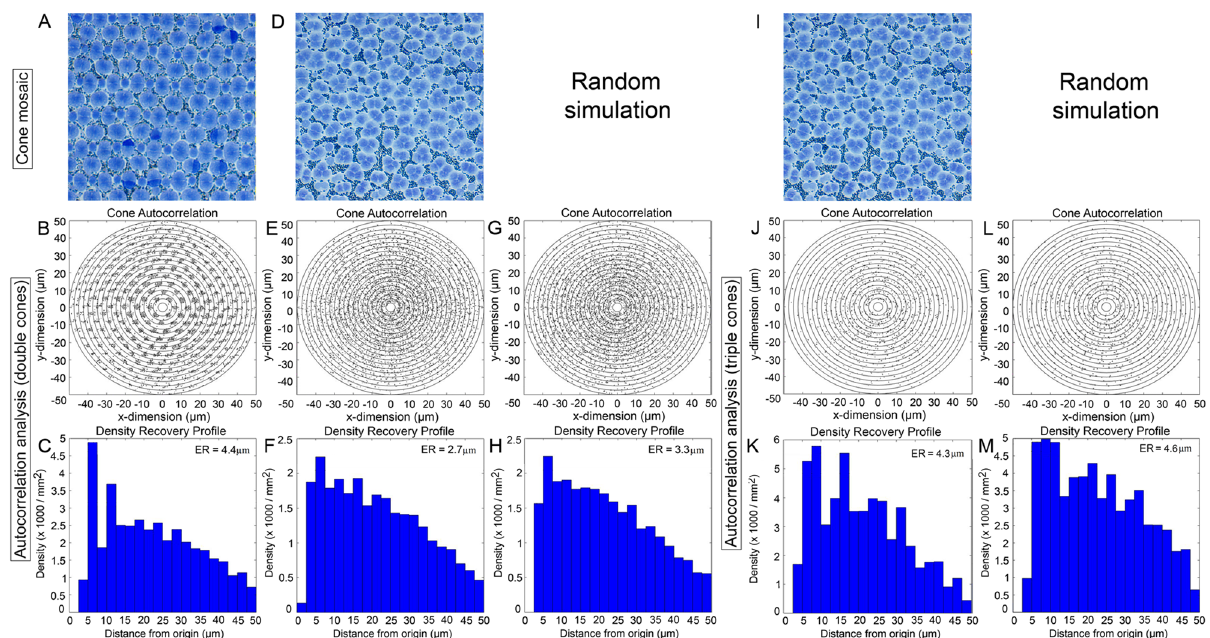
Figure 13. Autocorrelogram and density recovery profile for the double cone ( A – F ) and triple cone ( I – K ) distributions shown in Fig. 9, as well as the random distributions associated with the double cone ( G , H ) or triple cone ( L , M ) in the triple cone area. Presentation of data as per Fig.